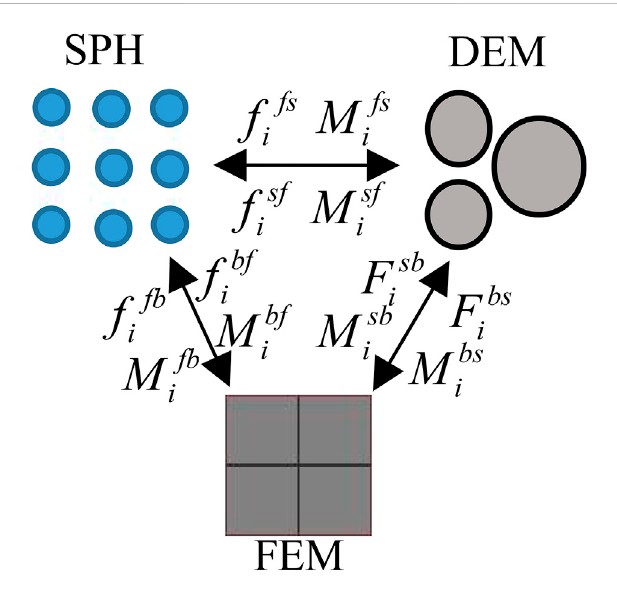
FIGURE 2 Schematic diagram of SPH-DEM-FEM coupling numerical model.